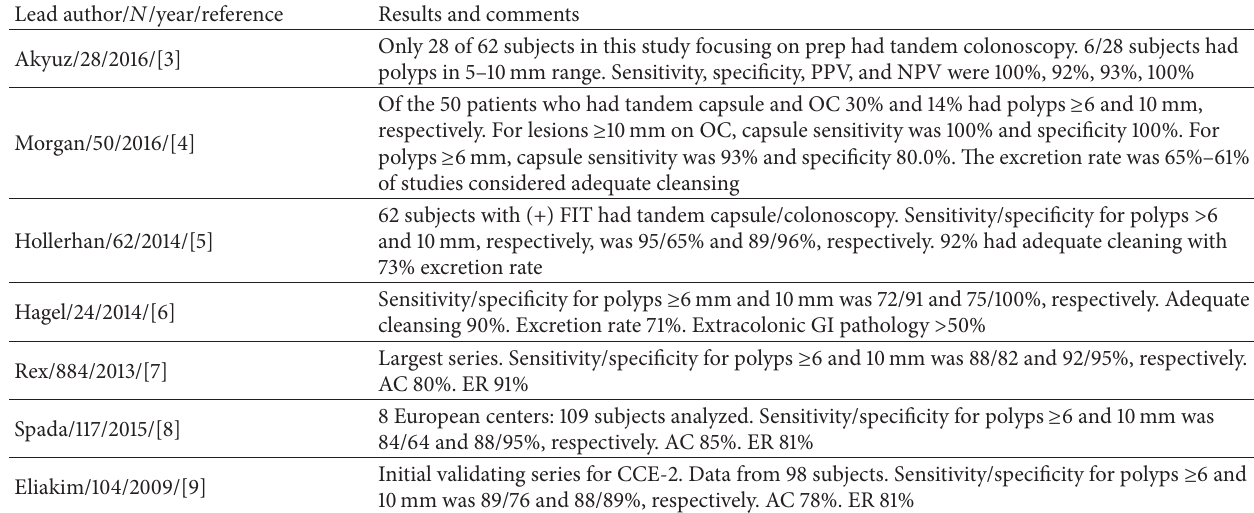
Table 2: PillCam COLON 2 in colon polyp and cancer